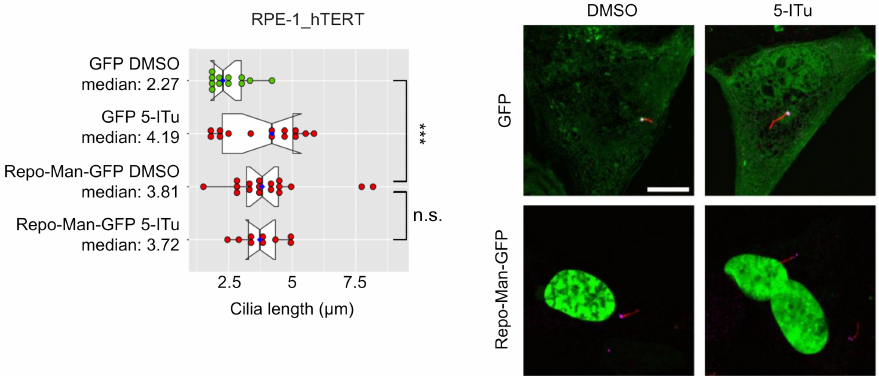
Figure 3. Loss of H3-Th3p causes an increase in cilia length. RPE-1_hTERT cells were transfected with a GFP- or Repo- Man-GFP- encoding plasmid and serum-starved for 24 h before being incubated, in serum-free media, with DMSO or 10 nM 5-iTU for a further 24 h. Cells were then fixed and processed for immunofluorescence against γ -tubulin (pink) and acetylated-tubulin (red). Representative images are shown (scale bar: 10 µ m). Graph shows the median cilia length calculated as described in Material and Methods; boxes include 50% of the data points, notch represent confidence interval (median ± 1.58 IQR/sqrt(n)). t -test was applied as a statistical measurement, n.s.; not significant, *** p <